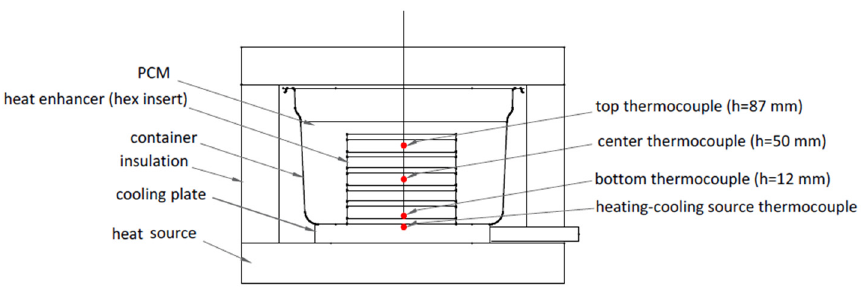
Figure 1. Test stand scheme: the thermocouples are placed in the center of the cells, in the middle of the structure.